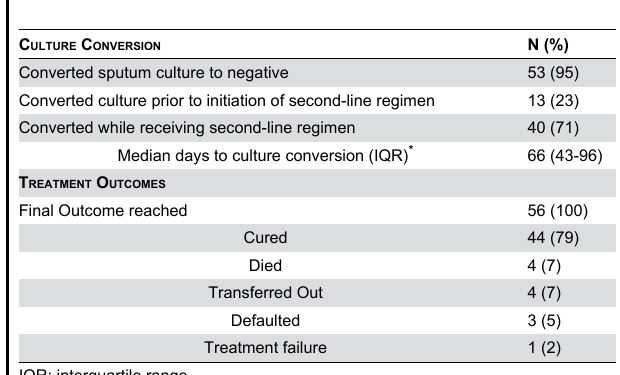
Table 3. Culture conversion and treatment